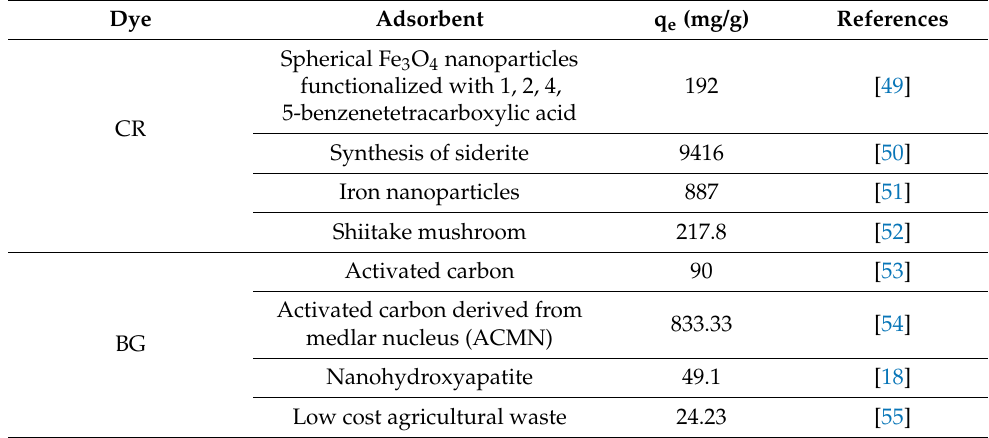
Table 4. Adsorption performance of CR and BG dyes onto different